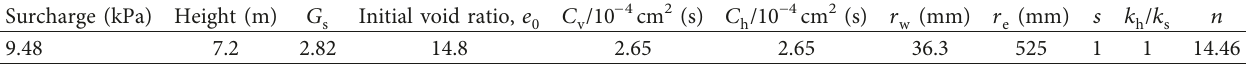
Table 1: Calculation parameters.